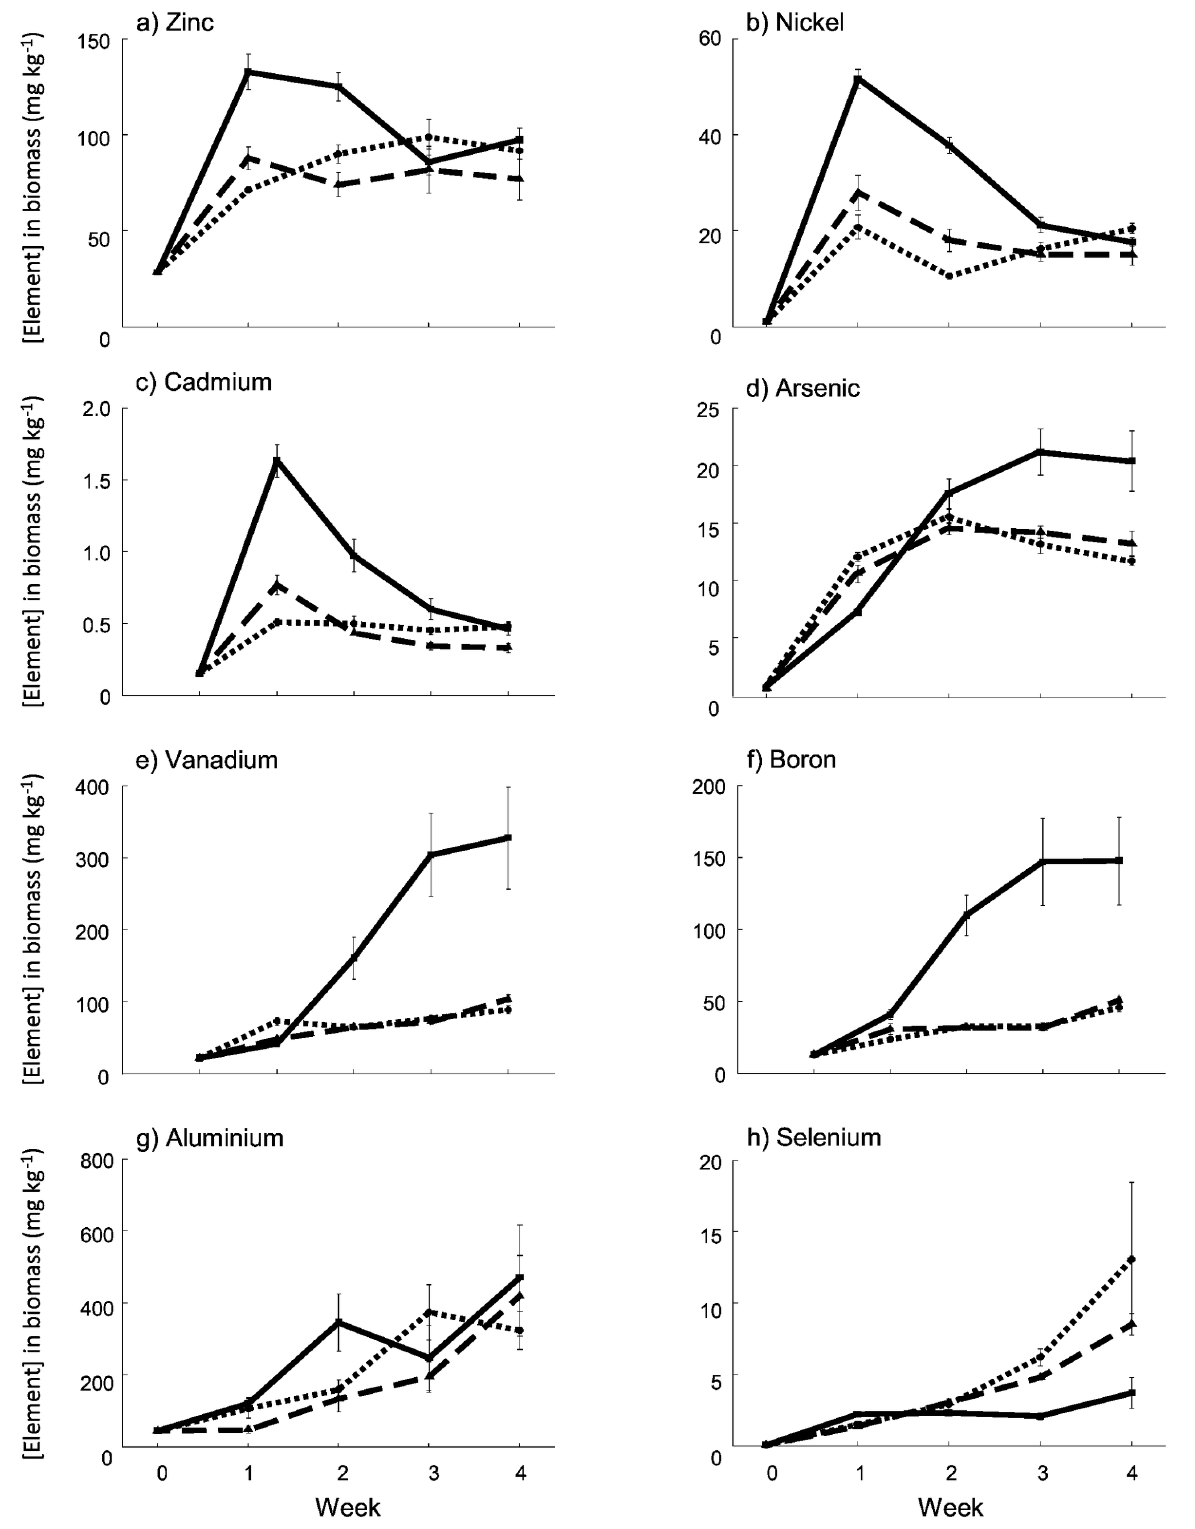
Figure 3. Metal and metalloid concentrations in Oedogonium sp. biomass cultured in Ash Dam Water at three levels of carbon supplementation. Unbroken, dashed and dotted lines show data for the 0, 3 and 6 L min -1 CO doi: 10.1371/journal.pone.0081631.g003 PLOS ONE |